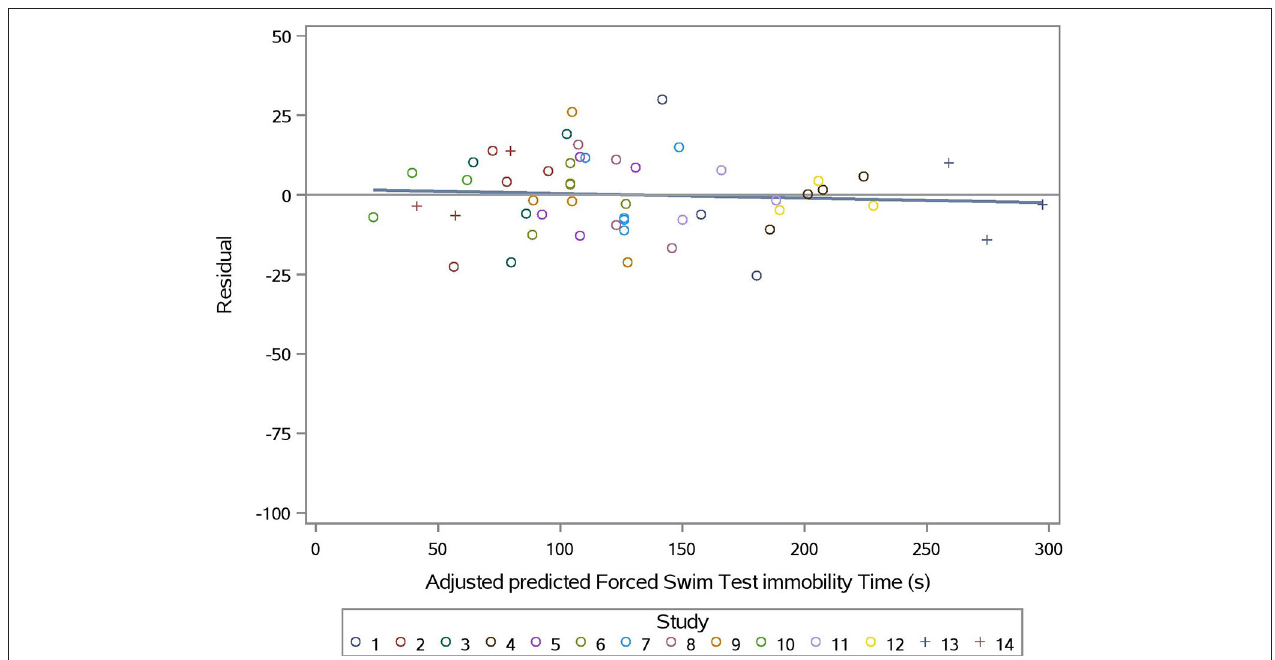
FIGURE 8 | Adjusted predicted FST immobility time (s) vs. Residual for prediction equation used in Model 3